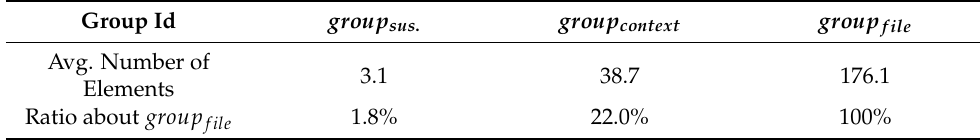
Table 2. Number of elements in ingredient pool.